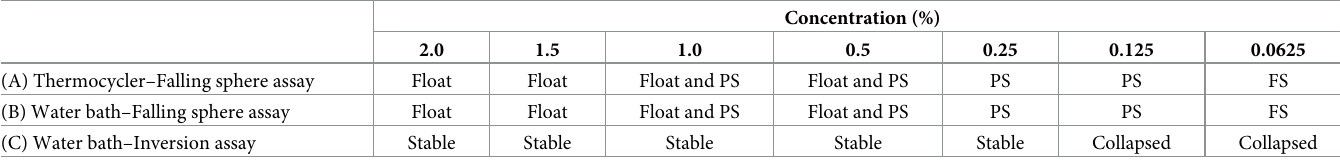
Table 2. Gelation results of potassium-supplemented κ